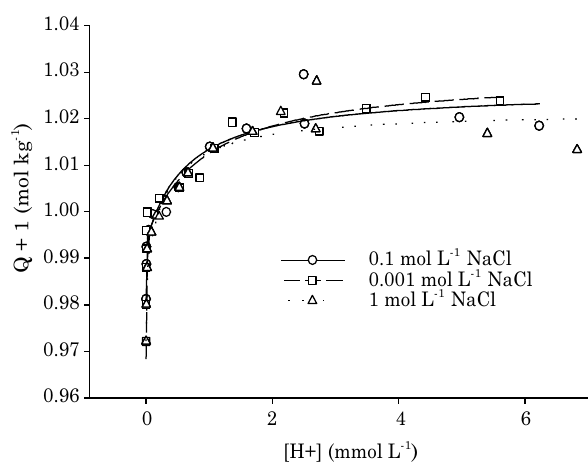
figure 2. Surface charge Q plus 1 versus [h + ] for an oxisol from paranavaí, pr, brazil.